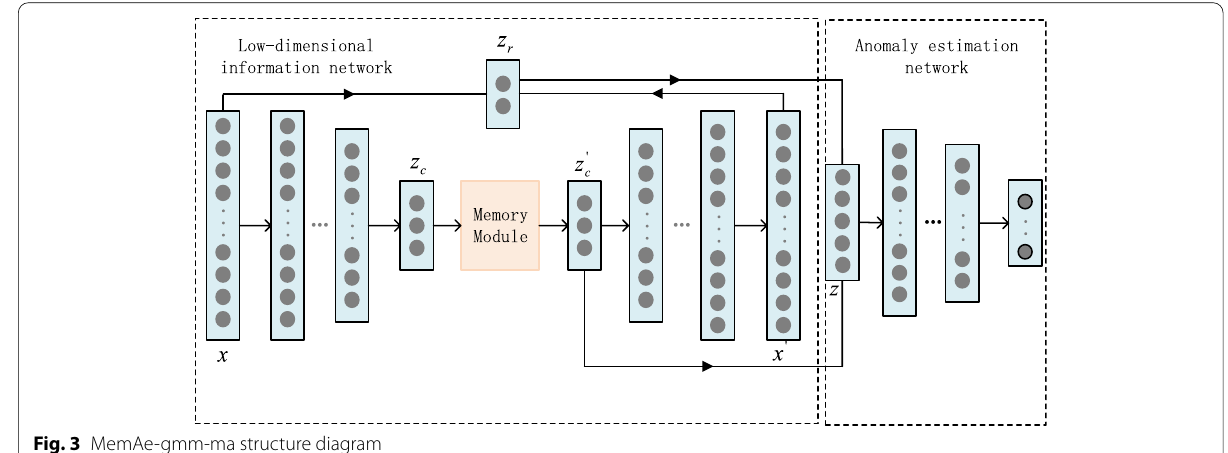
Fig. 3 MemAe-gmm-ma structure diagram